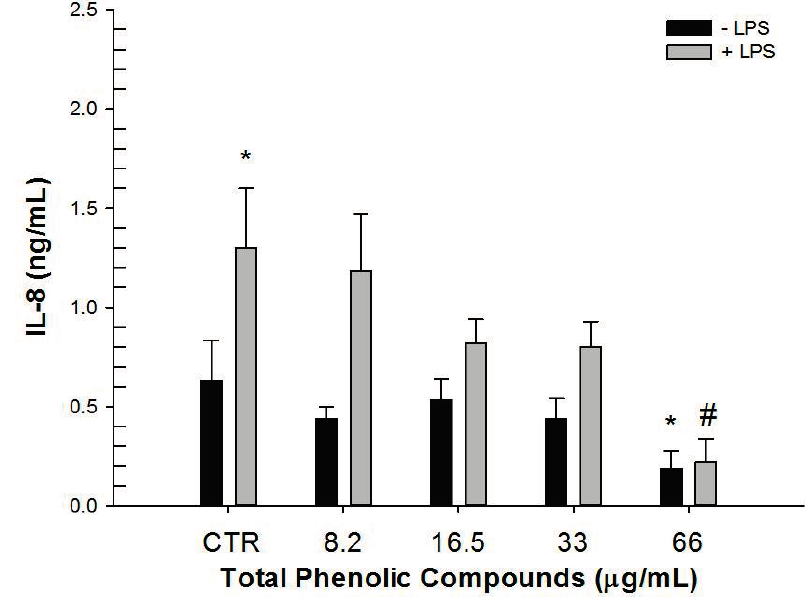
Figure 4. Basal ( − LPS) and stimulated (+LPS) IL-8 secretion levels produced by HT-29 human intestinal cell line treated with different phenolic acids concentrations from Duilio extract as compared to vehicle control (CTR). * p < 0.05 vs. CTR − LPS; # p < 0.05 vs. CTR + LPS ( n =